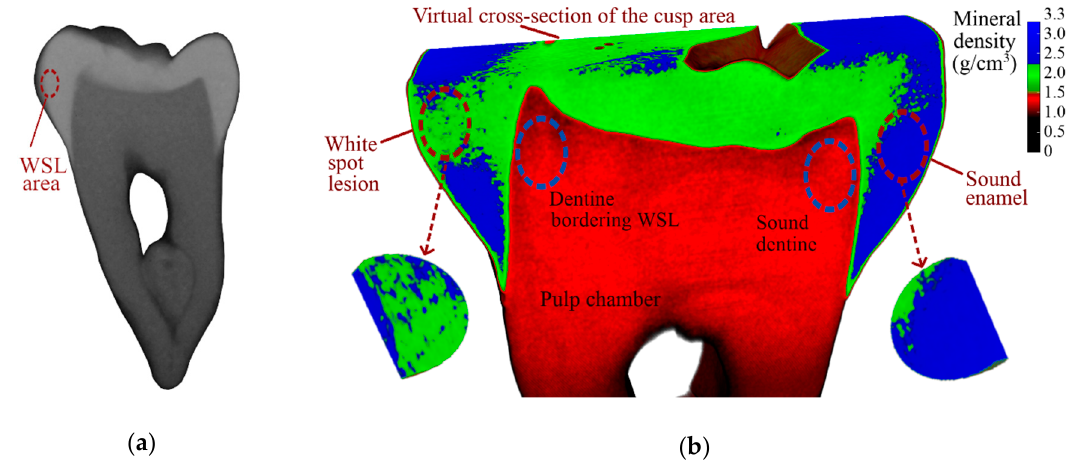
Figure 2. Mineral density research of the sample: ( a ) bitewing X-Ray image (exposure 0.5 s); ( b ) micro-CT (Cu + Al filter) with virtual tablets for the demineralized area of WSL and the sound enamel. Each tablet is cross-sectioned for better visualization of the mineral density by depth. Dentine bordering the WSL and sound dentine is marked with blue dashed ovals.